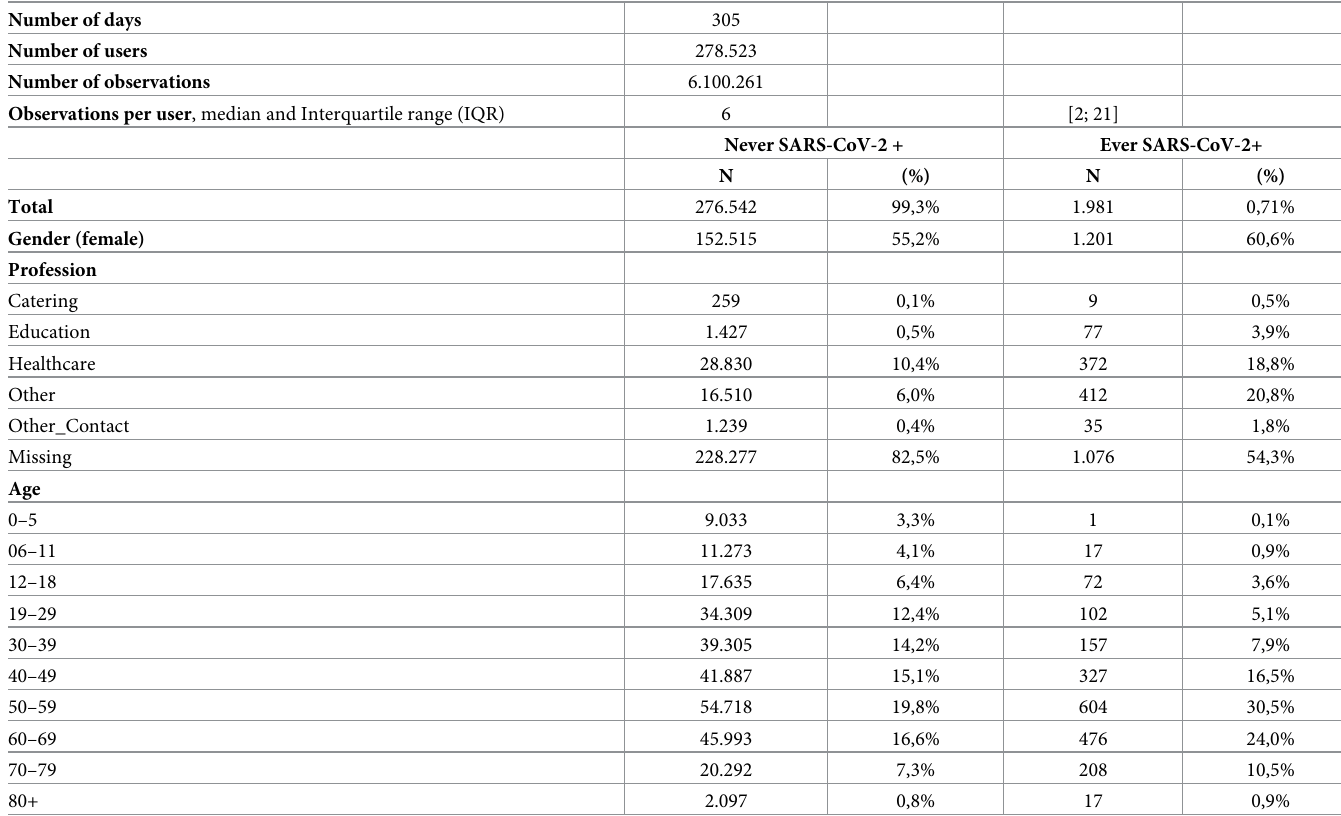
Table 1. Comparison of users never vs. ever tested SARS-CoV-2